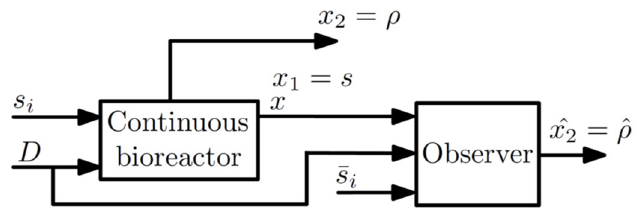
Figure 1. Structure of the observer application to microalgae bioreactor for estimating the specific substrate uptake rate 𝜌 .